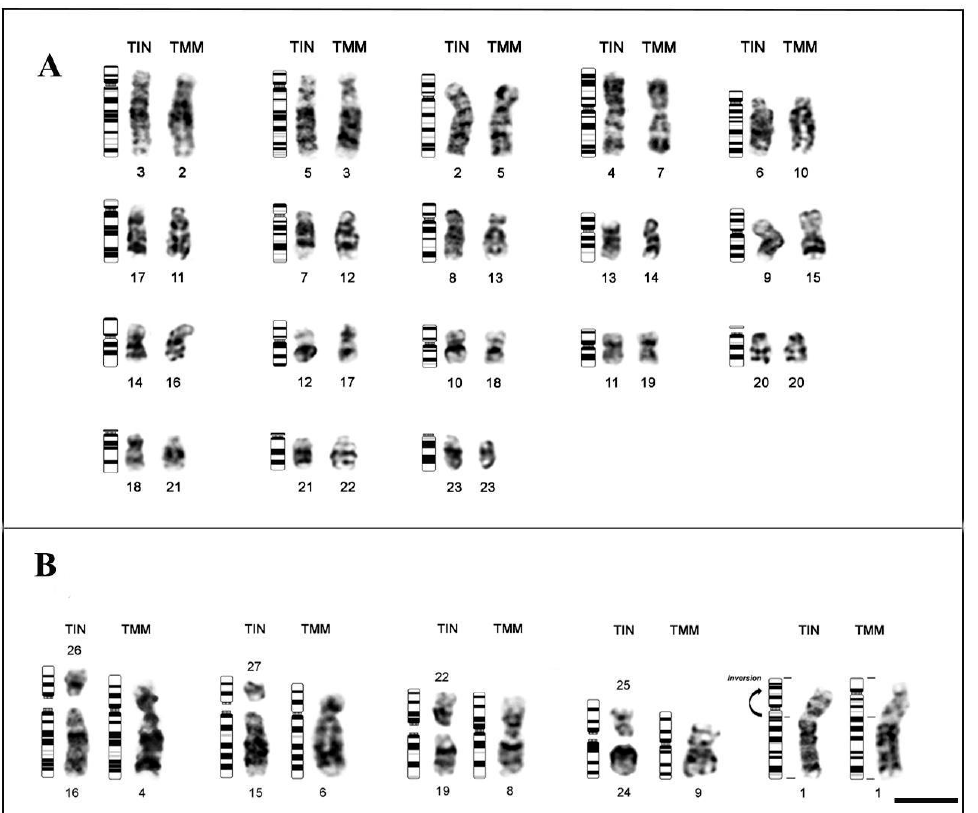
Figure 1. Karyotype of TIN ( A , B ) and TMM ( C , D ), after G-banding ( A , C ) and C-banding ( B , D ). In ( A , C ), an ideogram shows the pattern of G bands next to each chromosome pair. Bar 10 μ m.